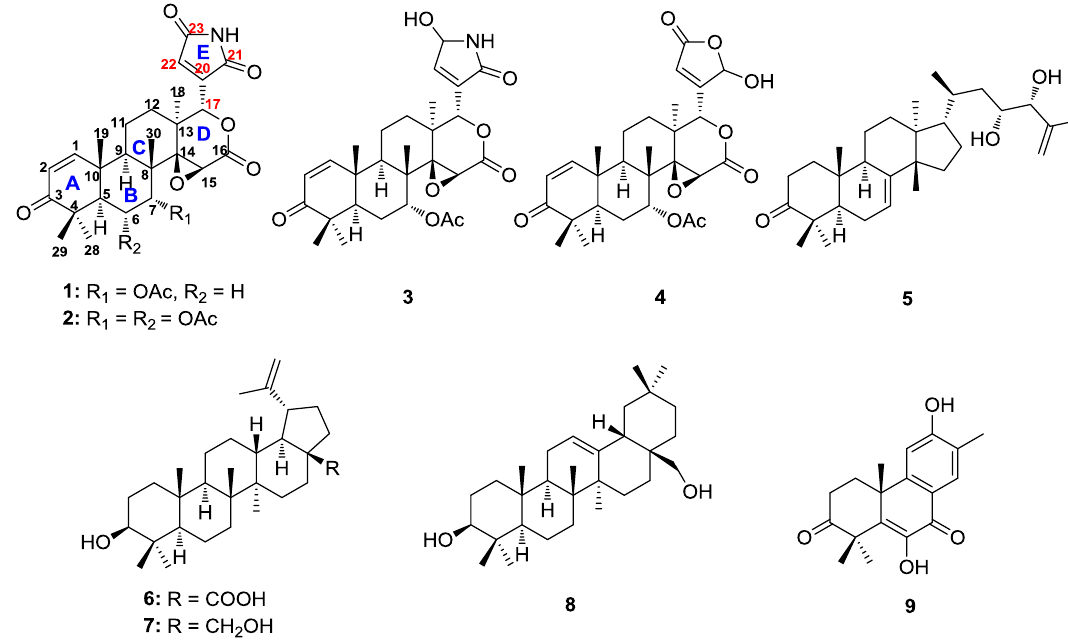
Fig. 1 Structures of compounds 1 – 9 isolated from the bark of Toona